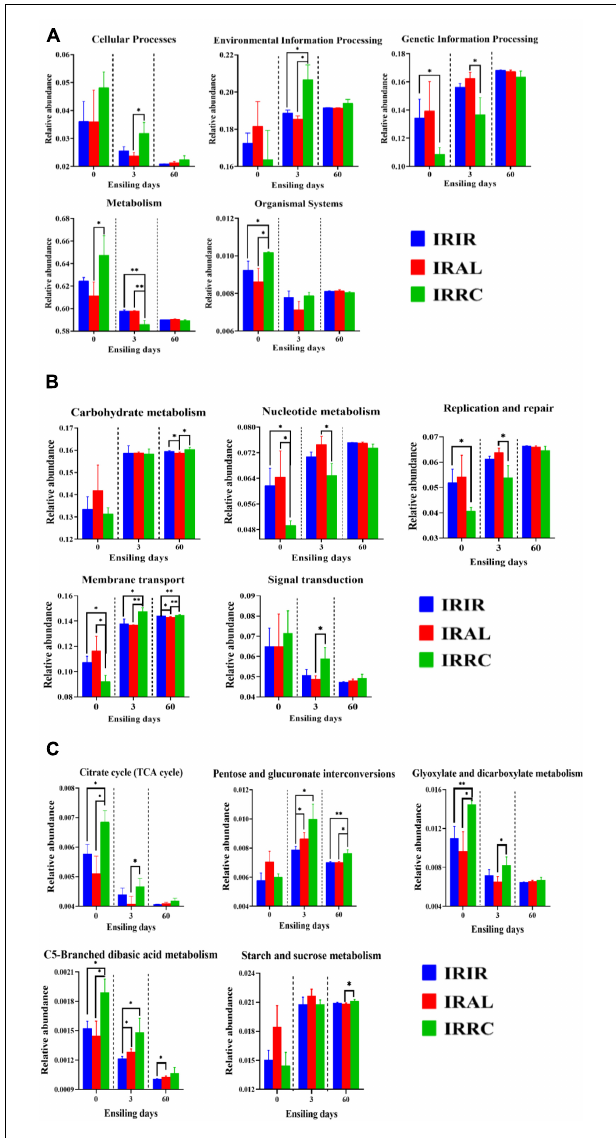
FIGURE 4 | The changes of KEGG metabolic pathways on the first (A) , second (B) , and carbohydrate pathway (C) levels obtained with Tax4Fun in different groups. KEGG, Kyoto Encyclopedia of Genes and Genomes; IRIR, sterile Italian ryegrass inoculated by epiphytic bacteria from Italian ryegrass; IRAL, sterile Italian ryegrass inoculated by epiphytic bacteria from alfalfa; IRRC, sterile Italian ryegrass inoculated by epiphytic bacteria from red clover. ∗ , 0.01 < p < 0.05; ∗∗ , 0.001 < p <